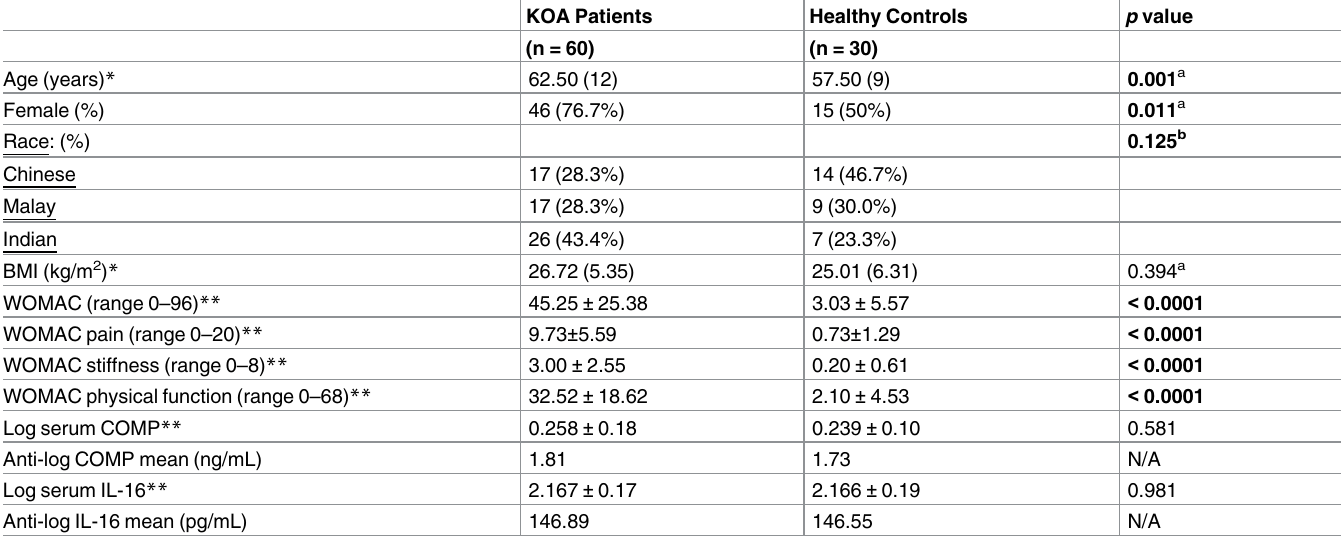
Table 1. Comparison between patients with knee osteoarthritis and healthy